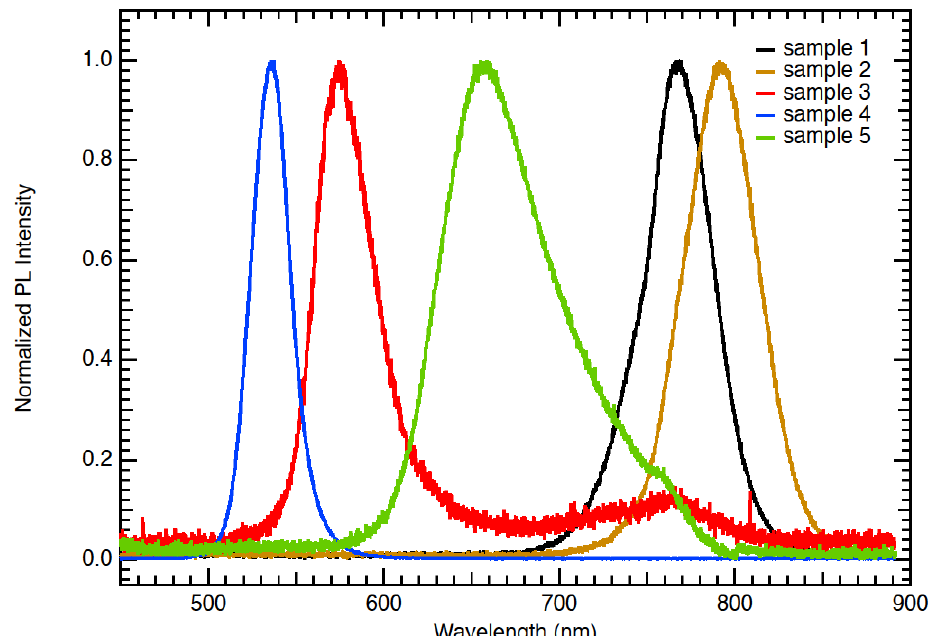
Figure 7. Normalised photoluminescence peaks of various compositions of the perovskite mate- rial. Group A (IR range) is represented by samples 1 and 2. Group B (UV range) is represented by samples 3 and 4. Group C (VIS range) is represented by sample 5. Sample 5 exhibited an emission peak at 655 nm, illustrating the PL peak emission can be controlled by composition changes. 655 nm, illustrating the PL peak emission can be controlled by composition